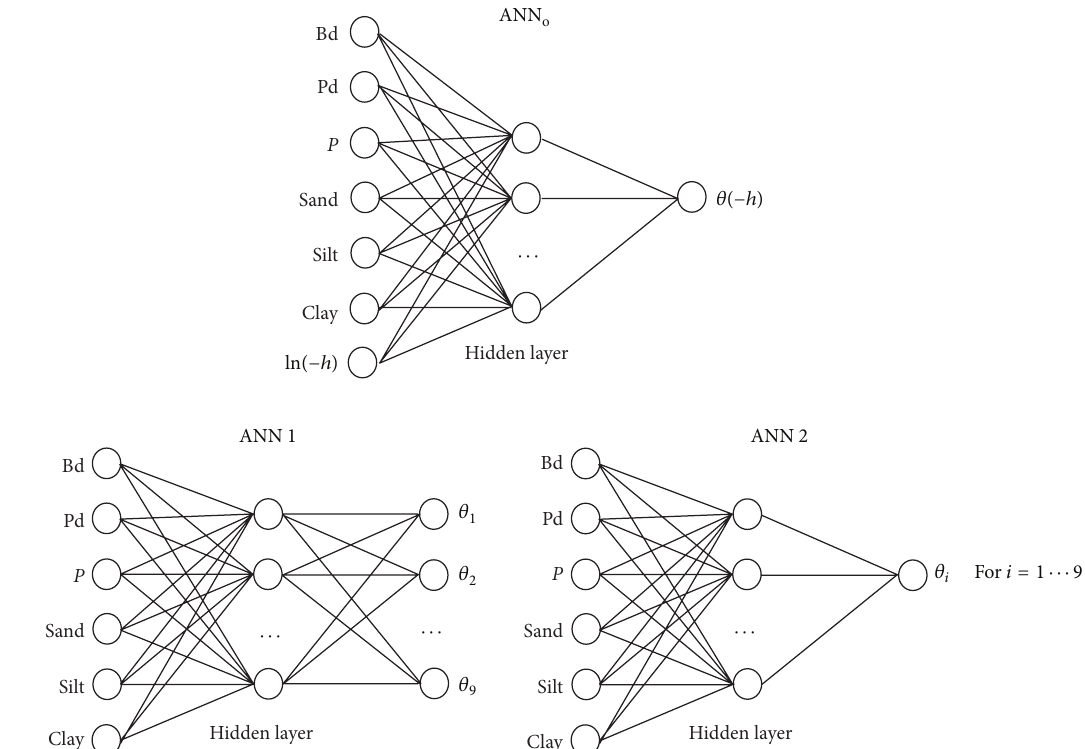
Figure 3: Models diagrams of the ANNs developed in this study. Bulk density (Bd), particle density (Pd), total porosity ( 𝑃 ), and sand, silt, and clay percentages are the common input predictors of the three models. In ANNs 1 and 2, 𝜃 𝑖 (for 𝑖 = 1 ⋅⋅ ⋅9 ) are the water content at the matric potentials 0, − 10, − 20, − 30, − 50, − 100, − 200, − 500, and − 1000 cm, respectively. In ANN 3, the matric potential (−ℎ) was considered as an additional predictor for estimating the corresponding water content 𝜃(−ℎ)